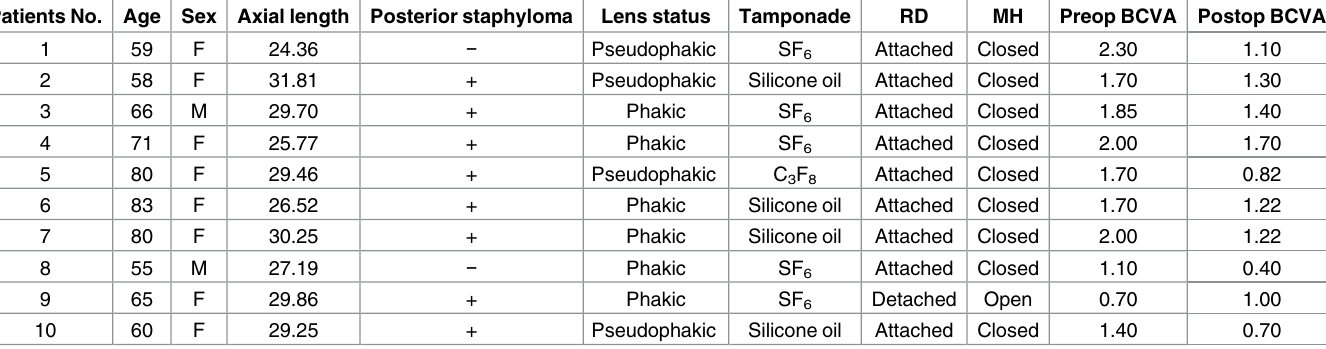
Table 2. Characteristics of patients underwent vitrectomy with inverted ILM flap technique for macular hole with retinal detachment. Patients No. Age Sex Axial length Posterior